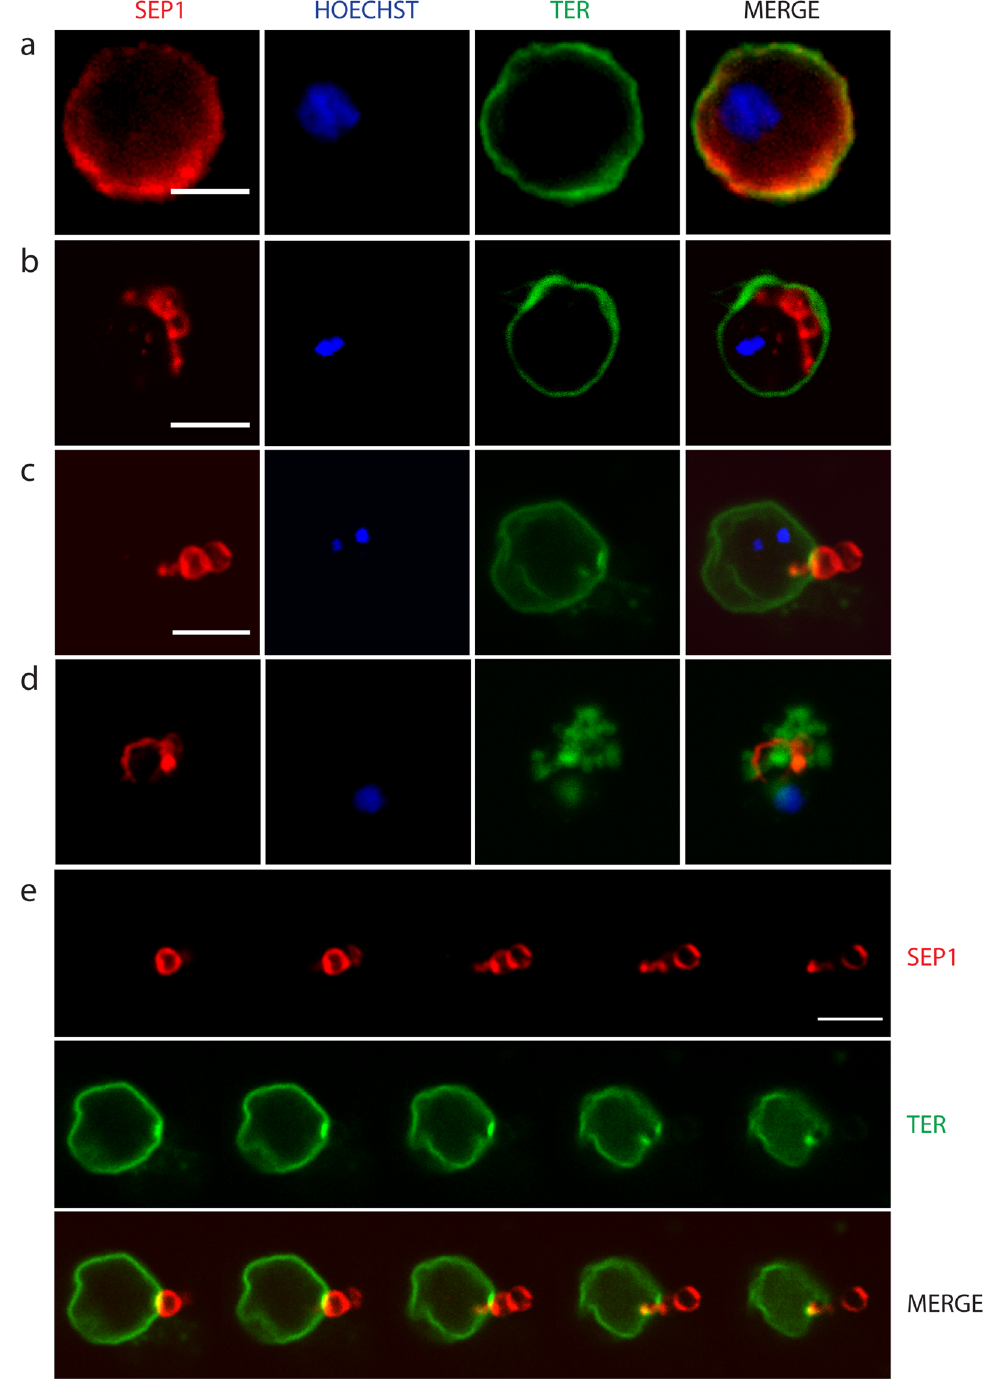
Figure 5. Labeling with SEP1 antibodies reveal PVM vesicles. Cells were labeled with the SEP1 antibody (red) and TER-119 (green) highlighting the PVM and RBCM, respectively. DNA is stained with Hoechst 33342 (blue). ( a – d ) Are projections of sections from confocal imaging. ( a ) Non-activated cell. ( b ) An activated cell. PVM vesicles have formed inside the intact RBCM. ( c ) The RBCM is opened at a single pore and SEP1 labeled vesicles are in the process of exiting. A montage of the same cell is shown in e. ( d ) A cell where egress is completed. Vesicles of RBCM and PVM are intermingled. ( e ) Montage of single sections of the cell in ( c ). Scale bar, 5 µ